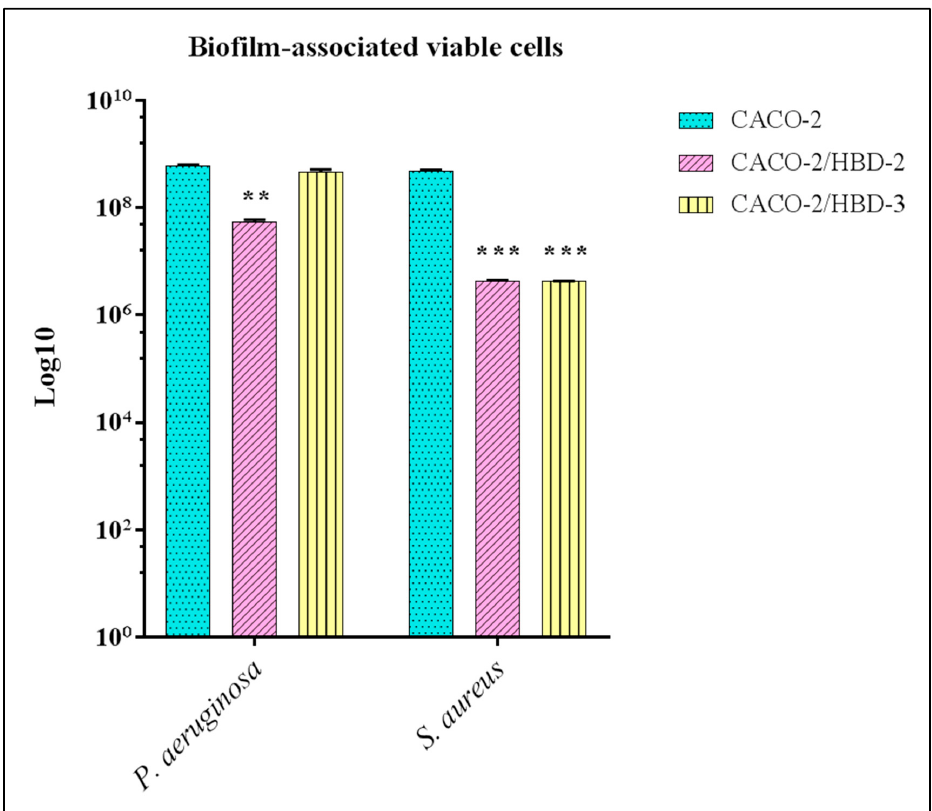
Figure 2. Viable cells counting of P. aeruginosa and S. aureus re-suspended in conditioned media of Caco-2, Caco-2/HBD-2 and Caco-2/HBD-3 after biofilm formation. Data are representative of three different experiments ± SD. Significant differences are indicated by ** p < 0.01, *** p < 0.001.